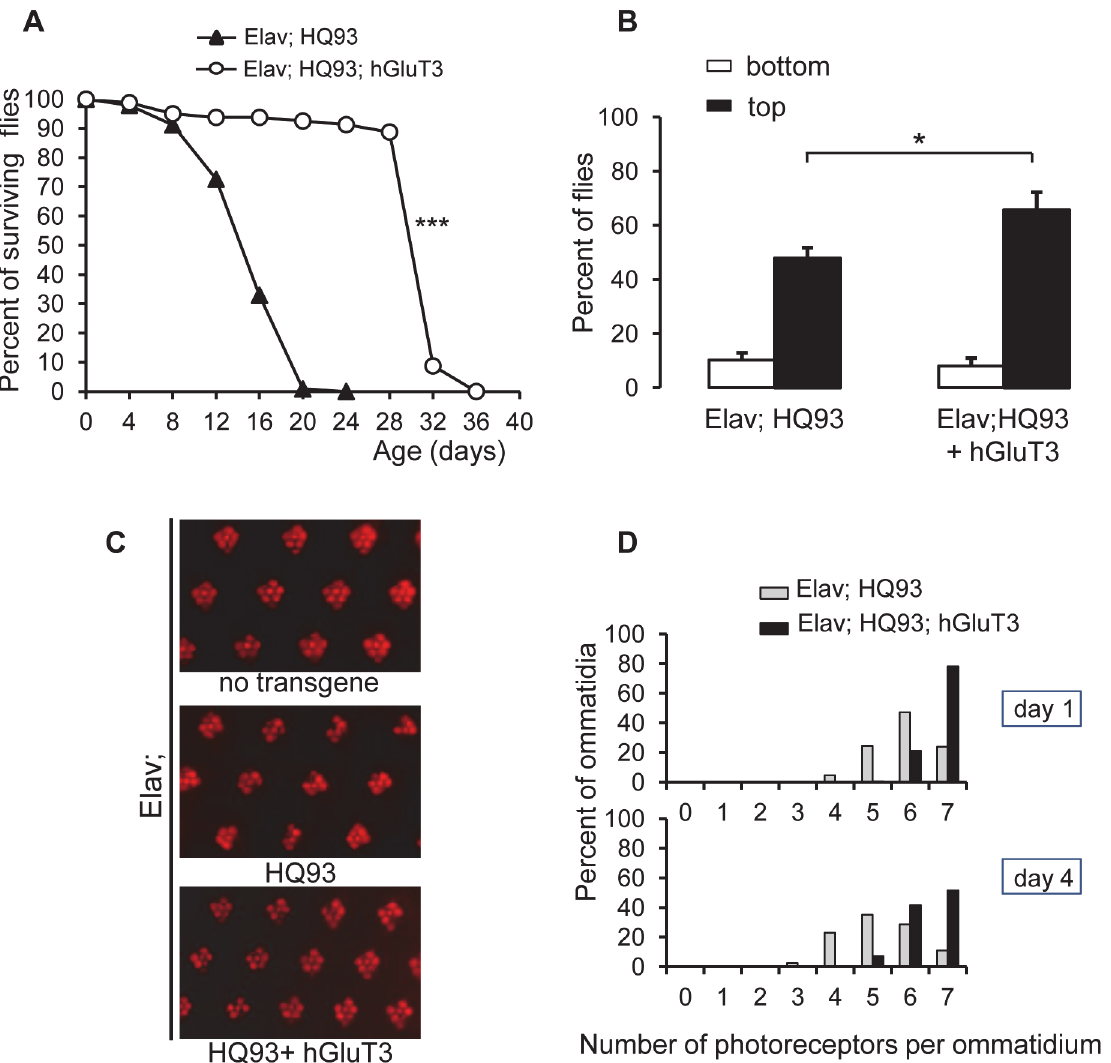
Fig 2. Overexpression of hGluT3 in neurons with HQ93 increases survival, rescues locomotor performance and neurodegeneration. ( A ): Typical survival curve of flies expressing the neuronal driver Elav- Gal4 and HQ93 (filled triangles) or HQ93 and hGluT3 (open circles) with n = 237 and 80 flies respectively. The log-rank test indicates that the two survival curves were very different ( *** ; p < 0.0001). ( B ): Locomotor performance evaluated by negative geotaxis test on 12 day-old flies expressing the indicated transgenes under the neuronal Elav- Gal4 driver. Open columns indicate the percentages of flies remaining at the bottom of the column; filled columns indicate the percentages of flies climbing to the top. Results were the means + SEM of the percentages obtained from a representative experiment (n = 55; 54 flies respectively for each genotype). Comparisons were performed by Student ’ s t-test ( * , p = 0.0239). ( C ): Representative deep pseudopupil photomicrographs of eyes from 4-day old flies expressing no transgene (control), HQ93 alone, or HQ93 and hGluT3 under the control of Elav- Gal4. ( D ): Photoreceptor frequency distributions in 1- or 4-day old flies expressing HQ93 alone, or HQ93 and hGluT3 . Statistical significance testing the median value of photoreceptor number per ommatidium was determined by Mann-Whitney test (one-tailed) (p <